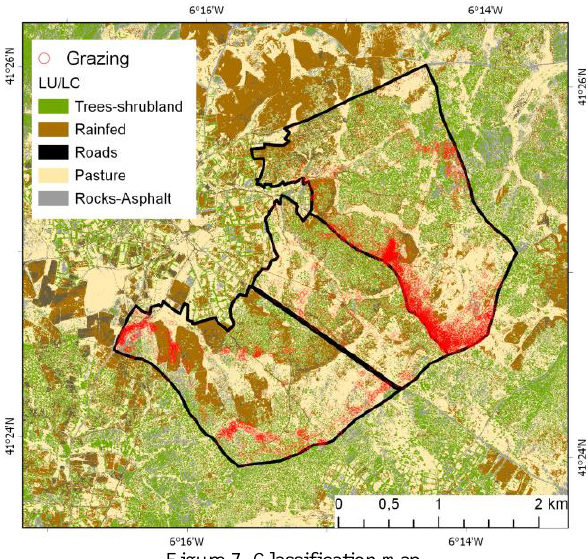
Figure 7. Classification